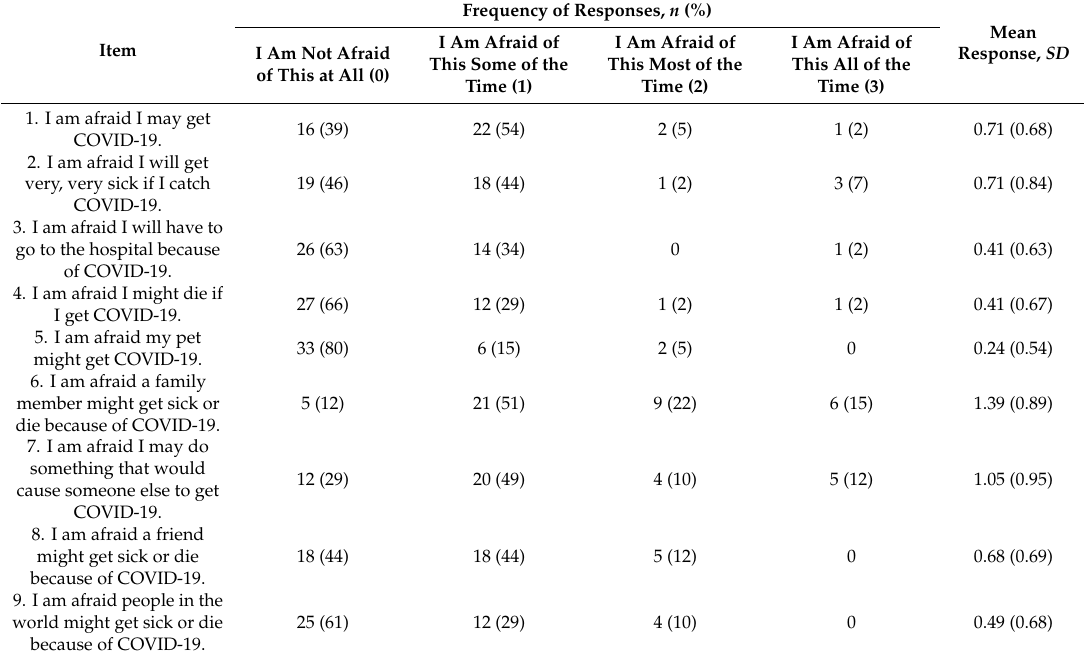
Table 2. Results of COVID-19 Questionnaire items concerning fear of